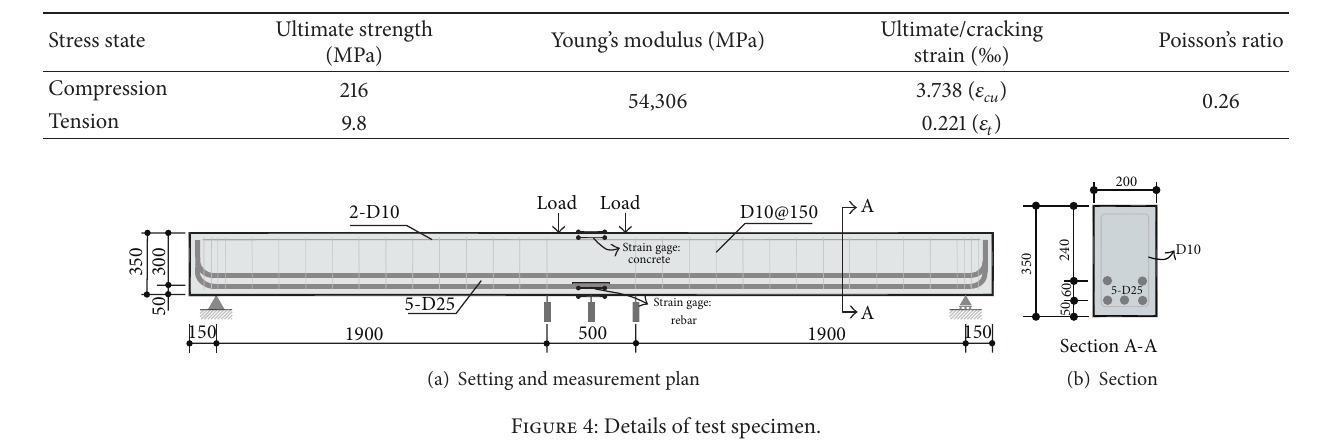
Table 3: Mechanical characteristics of concrete.